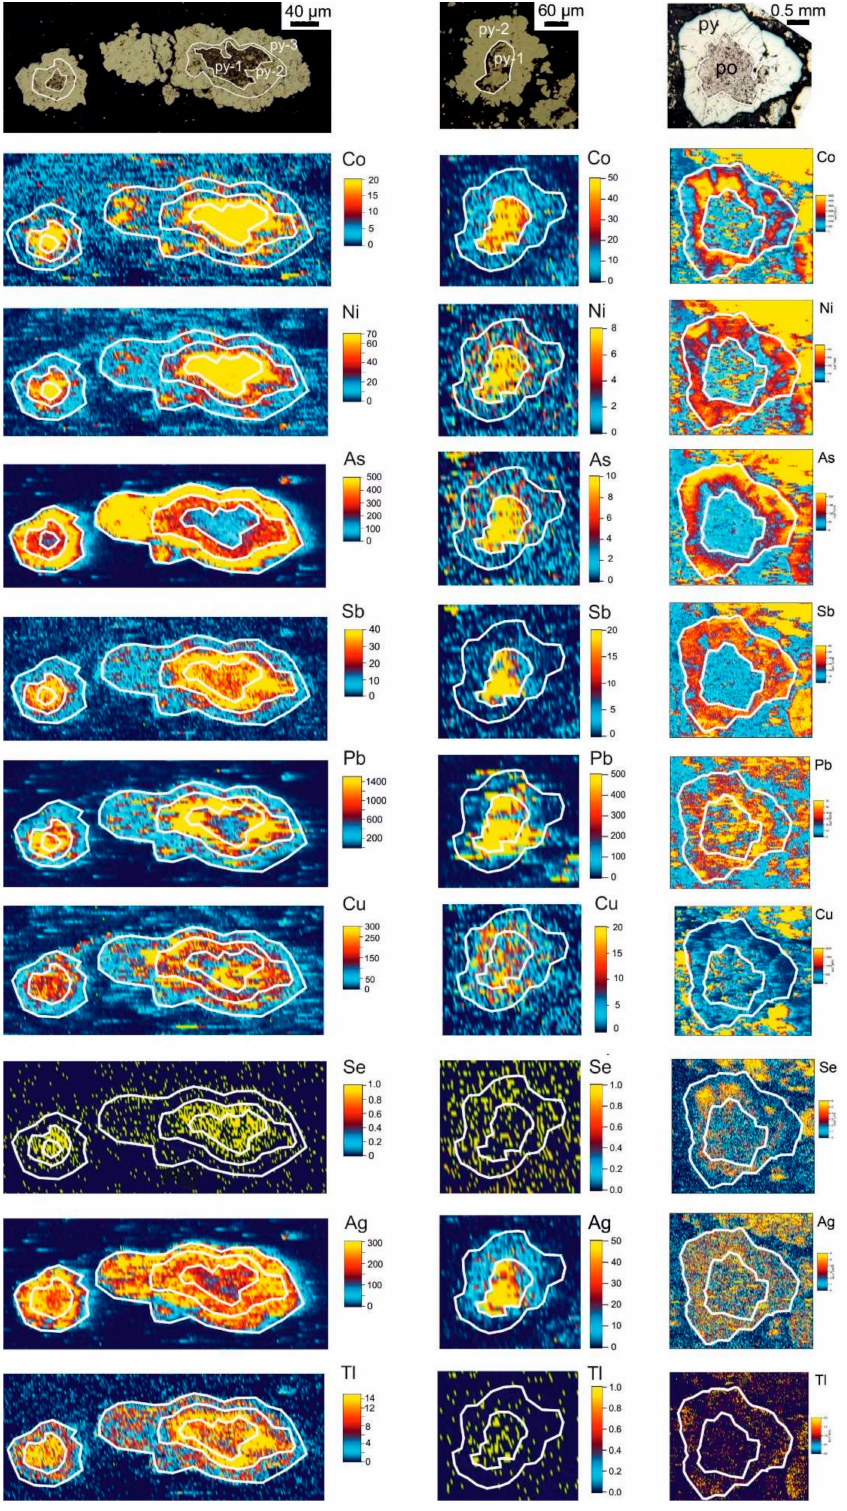
Figure 8. LA-ICP-MS pattern for selected trace elements of sulfide nodules from sulfide–black shale, sulfide–carbonate–hyaloclastite, and sulfide–serpentinite diagenites of the Saf’yanovskoe, Talgan, and Dergamysh deposits,